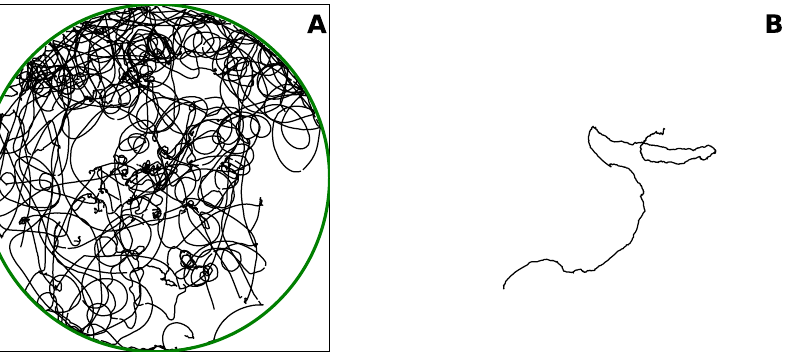
Figure 1. Visualizations of aphid movement in experiment. (A) Trajectories of 28 aphids during approximately 15 min of one experimental trial, as determined by motion tracking of video data. The green circle is the experimental arena with radius 20 cm . (B) Blow-up of a subset of a single aphid trajectory, shown in a 10 cm 6 10 cm zoom.